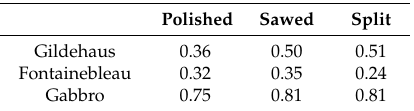
Figure 6. Mean emissivity spectra and normalized mean emissivity spectra of the Gildehaus ( a , b ), Fontainebleau ( c , d ), and Gabbro ( e , f ) emissivity measurements. Circles and arrow indicate spectral shape changes. Table 4. Reflectance maxima of emissivity